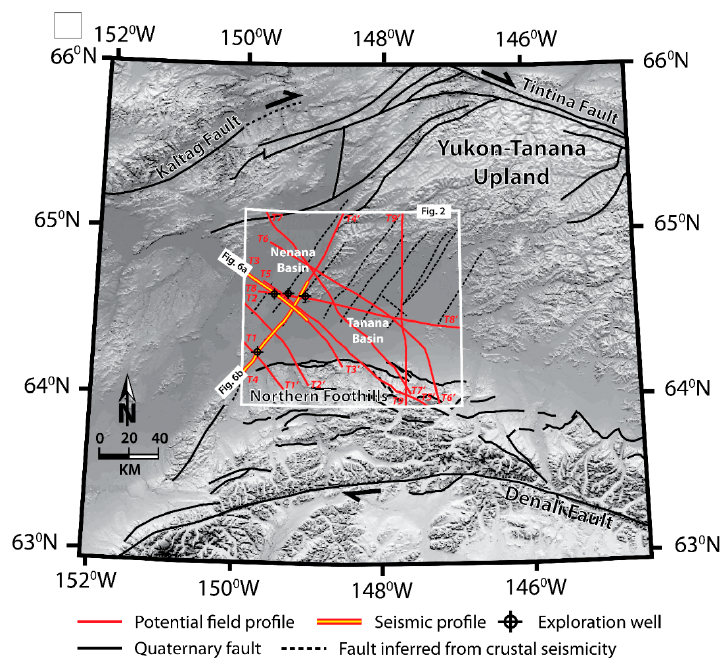
Figure 3. Location of the presented geophysical transects relative to the major structural features of central Alaska. Four profiles (T1 to T4) entirely lie within the southern part of the Nenana basin and coincide with 2D seismic profiles (courtesy of ConocoPhillips). The northwestern segments of four additional profiles (T5 to T8) extend from the northwestern margin of the northern Nenana basin to the eastern and southern margin of the Tanana basin and transect the inferred geologic boundary between the two basins. Profile T9 is a south-to-north profile that starts at the northern foothills of the Central Alaska Range, extending northward across the basin, and ends in the Yu- kon-Tanana Upland, north of the Tanana basin.